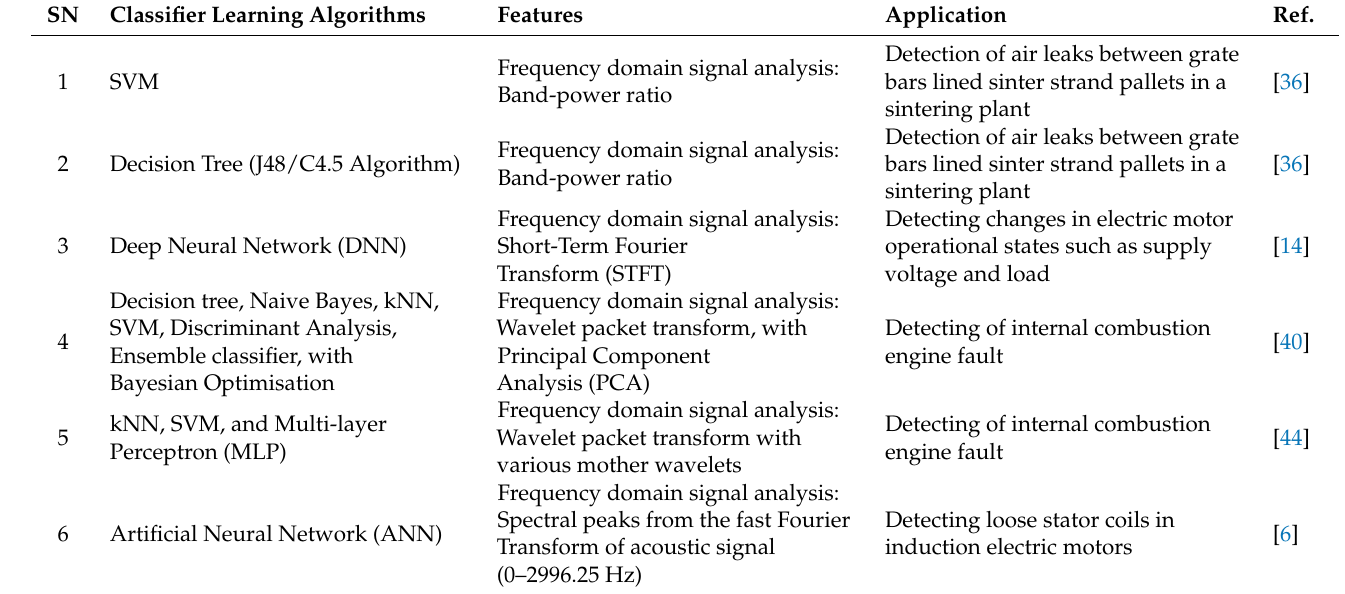
Figure 3. Structure of an artificial neural network (ANN) ( a ) ANN ( b ) single neuron or node ( c ) optimizing weights using gradient descent. Table 5. Exemplar classifier learning algorithm for classification of machine operating sounds.